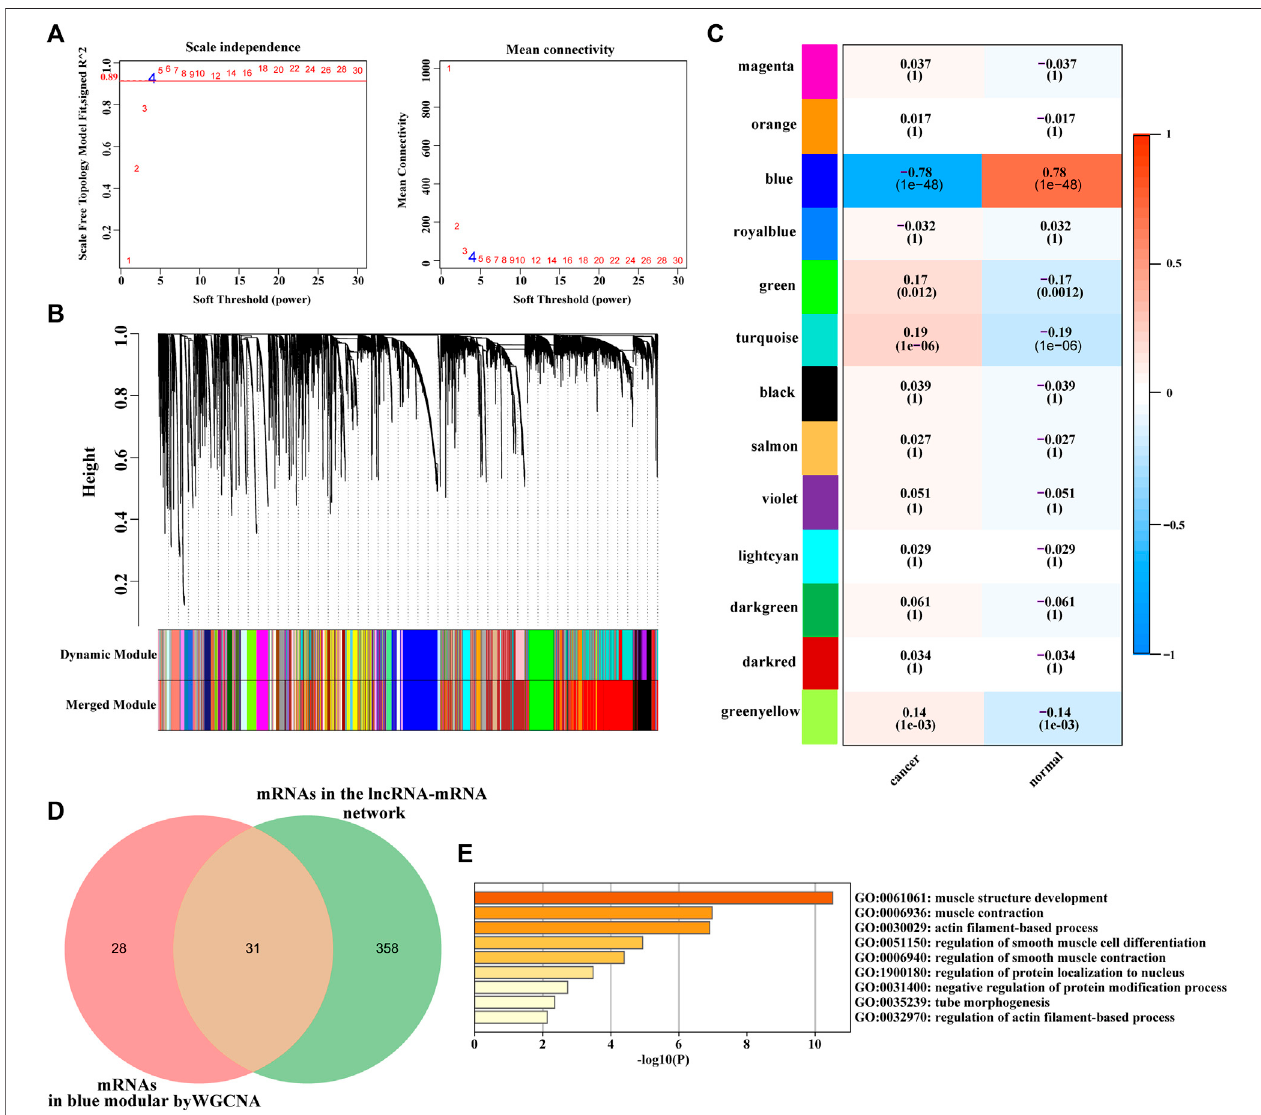
FIGURE 5 | (A) (left): Analysis of the scale-free fi t index for various soft-thresholding powers. (A) (right): Analysis of the mean connectivity for various soft- thresholdingpowers.Theredlinerepresentedthesquareofthecorrelationcoef fi cient,0.89,andthe fi rstpointaboveredlinewasthesoftthreshold β (cid:1) 4. (B) Hierarchical cluster analysis of mRNAs (the median absolute deviation (MAD) > 50%) was conducted to detect co-expression clusters with corresponding color assignments. Each color represents a module in the constructed gene co-expression network by WGCNA. (C) Heat map of the correlation between modules and traits. The box includesthePearsoncorrelationcoef fi cient(PCC)andthecorresponding p -value.Theboxcolor(rangesfrombluetored)iscorrelatedwiththePCCvalue(rangefrom – 1 to1).Theredboxindicatesthemoduleispositivelycorrelatedwithtraits,whiletheblueboxindicatesthemoduleisnegativelycorrelatedwithtraits.Thetraitsinthisstudy werebladdercancerstatus(cancerandnormal). (D) VenndiagramofdifferentiallyexpressedmRNAsinlncRNA-mRNAcoexpressionnetworkandmRNAsscreenedvia WGCNAinTCGAbladdercancerdataset. (E) TheBargraphshowstheenrichedtermsof31mRNAsusingMetascape(http://metascape.org/),coloredby p -values.Adj. p -value < 0.05 were considered statistically signi fi cant. The darker the color, the greater the p -value.